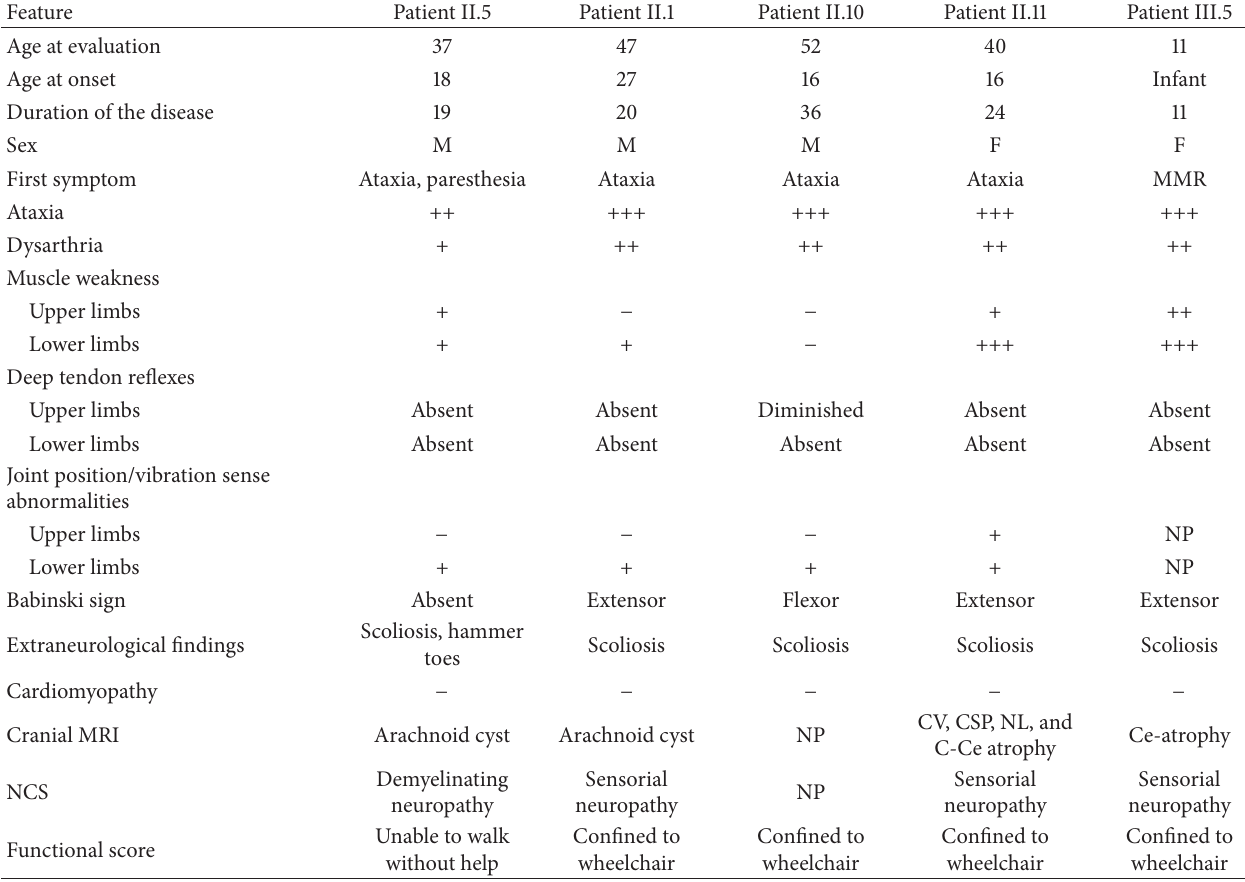
Table 1: Clinical and laboratory characteristics of the patients.